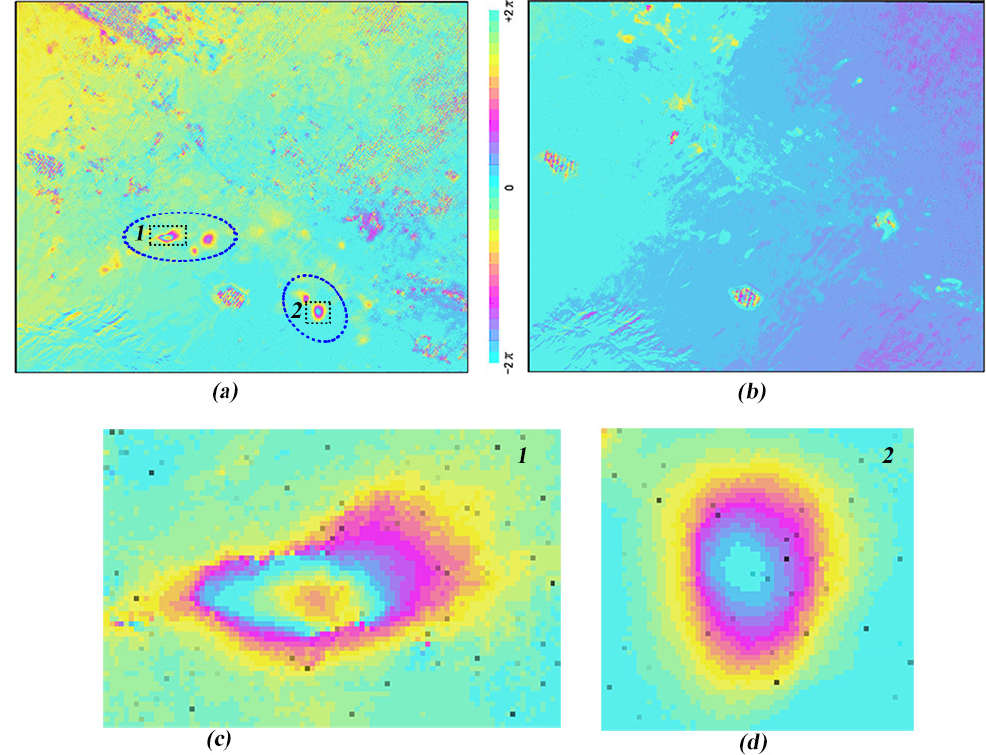
Figure 4. Differential interferograms generated from the data pair ( a ) (20 January 2007 and 10 December 2008, B p = 643 m) and ( b ) (10 December 2008 and 25 January 2009, B p = 472 m) after the removal of topographic phase and noise filtering; ( c , d ) are the close ‐ up view of a typical fringe maps, where the locations are indicated by the black dashed lines in ( a ).